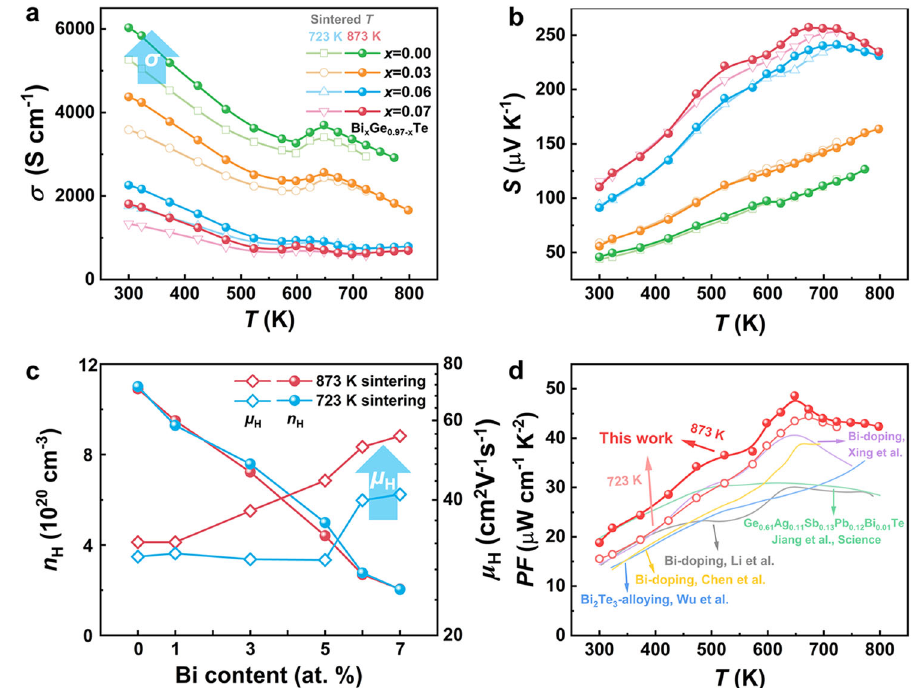
Fig. 4 | The electrical transport properties. Temperature-dependent a σ and b S for the Bi x Ge 0.97 – x Te-723 and Bi x Ge 0.97 – x Te-873 samples. c Hall carrier concentra- tion and μ H for the Bi x Ge 0.97 – x Te-723 and Bi x Ge 0.97 – x Te-873 samples at